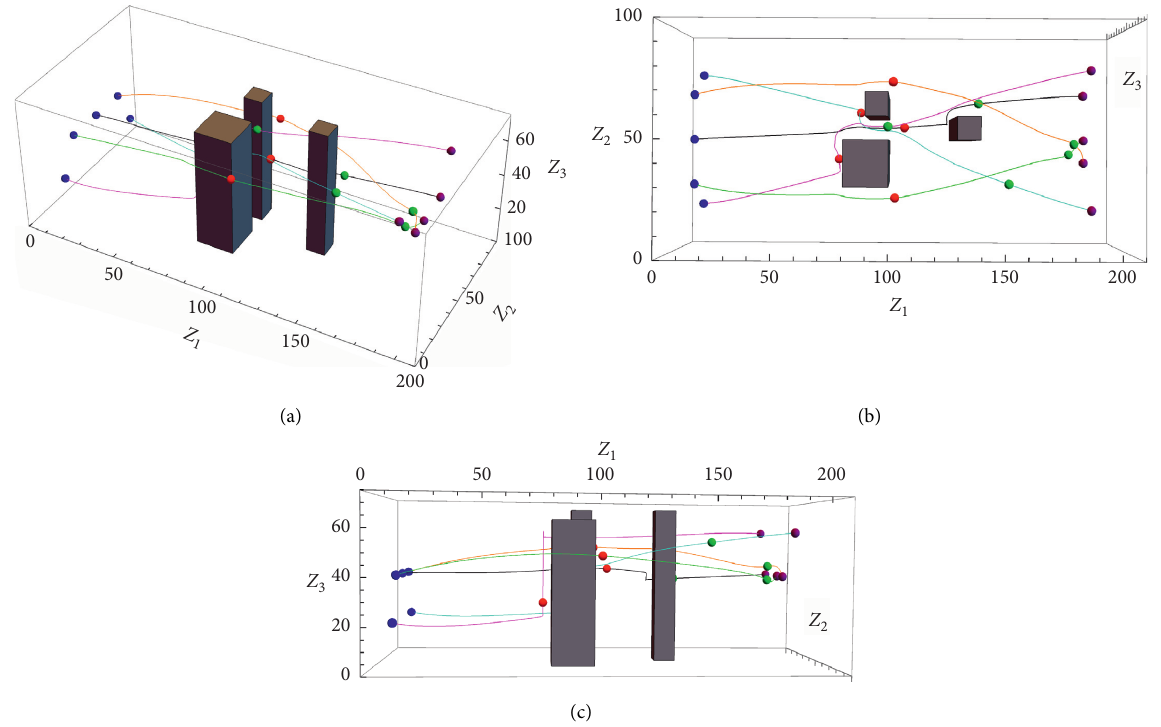
Figure 8: Scenario 2. The different viewpoints of P i while it is in motion to its target with towers constructed from the rectangular planes. (a) Default 3D motion view. (b) Top 3D motion view. (c) Front 3D motion view. Table 2: Scenario 2. The parameters utilised in the numerical simulation, with n � 3 and m � 15. Description